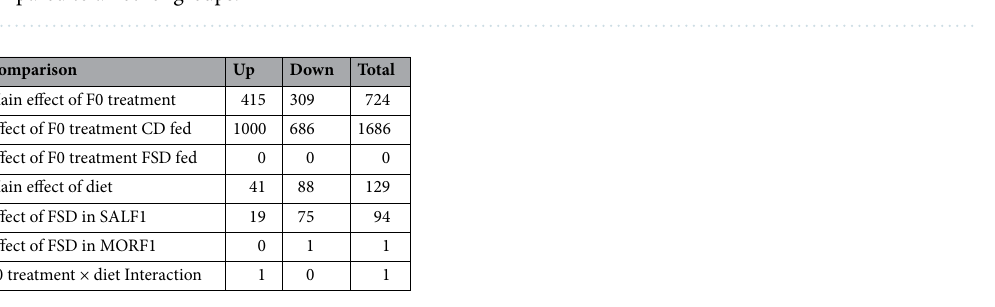
Figure 4. Panel ( A ): MDS Plot comparing all groups. Panel ( B ): Volcano plot of significant differential gene expression when comparing CD maintained MORF1 and SALF1 males. Panel ( C ): V Volcano plot of significant differential gene expression when comparing FSD maintained SALF1 and CD maintained SALF1 males. Panels ( A – C ) N = 6/group. Relative expression of Gnα12 (top) and Plekhh2 (bottom) in punch biopsies of liver samples taken after a 24 h fast. SALF1 CD N = 6; SALF1 FSD N = 6; MORF1 CD N = 7; MORF1 FSD N = 7; * p < 0.05 as compared to all other groups.